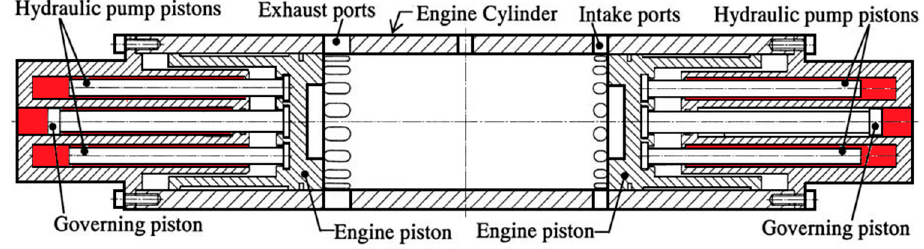
Figure 19. The structure of a dual-piston HFPE in Toyohashi Polytechnic University [49].